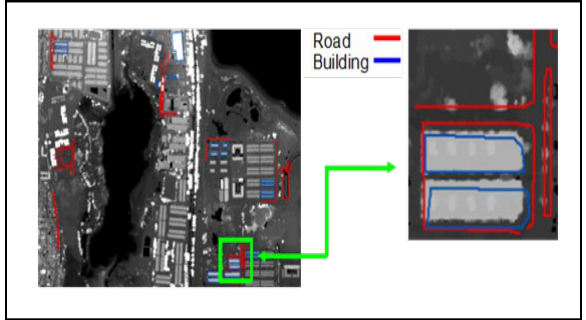
Figure 6. Vector line derived from ground survey overlay with LiDAR DSM plotted at scale 1:10,000 and zoom at scale